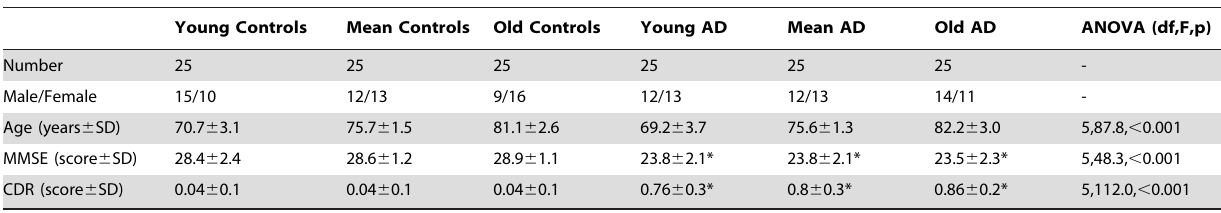
Table 2. Subject group characteristics for